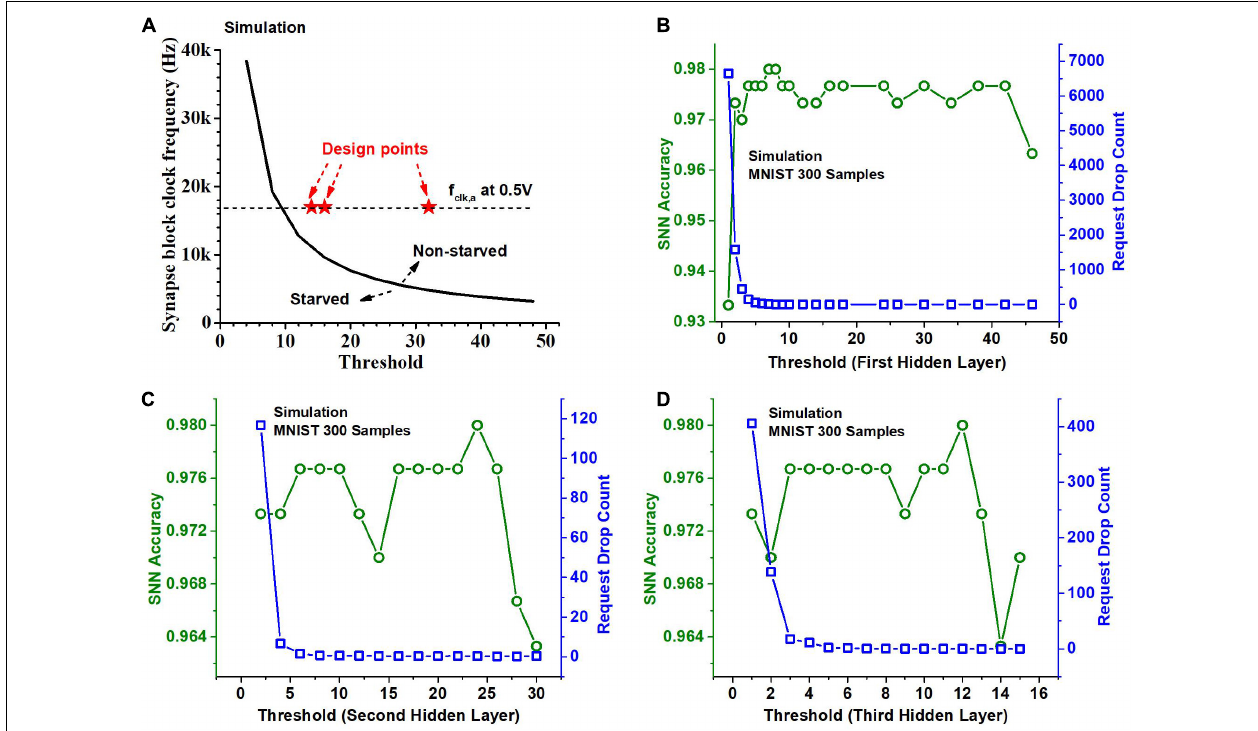
FIGURE 7 | (A) Threshold and clock frequency optimization for no starvation during operation. Neurons are not starved when the arbiter clock frequency and the threshold for the layer are high enough. (B) SNN accuracy on 300 samples of the MNIST dataset and the total number of neuron requests dropped (request drop count) per sample when the threshold value for the 1st hidden layer is varied. (C) SNN accuracy and Request drop count when the threshold value for the 2nd hidden layer is varied. (D) SNN accuracy and Request drop count when the threshold for the 3rd hidden layer is